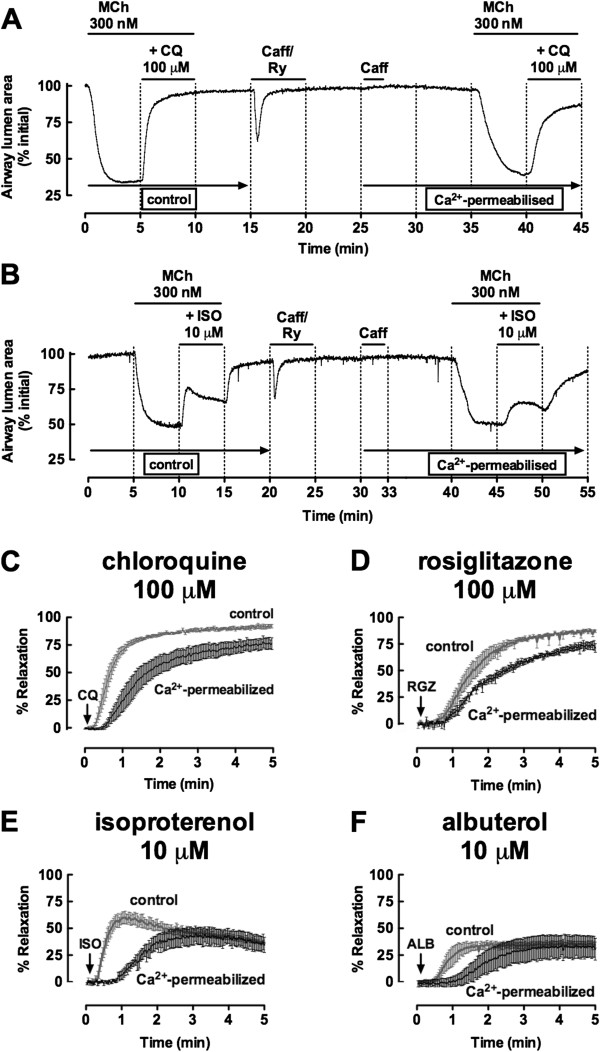
Rosiglitazone and chloroquine and oppose airway contraction due to calcium sensitivity. Small airways in lung slices were pre-contracted with 300 nM methacholine (MCh), prior to perfusion with dilators for 5 min. Representative traces show changes in airway lumen area for relaxation to A) chloroquine (CQ) and B) isoproterenol (ISO) before and after treatment with caffeine/ryanodine. Grouped data for C) CQ (100 μM), D) rosiglitazone (RGZ, 100 μM), E) ISO (10 μM) and F) albuterol (ALB, 10 μM) (n = 4/group) show pre- and post-caffeine/ryanodine responses within the same slice. Responses (mean ± S.E.M) represent the% relaxation of the MCh pre-contraction measured at 2 sec intervals over 5 min.